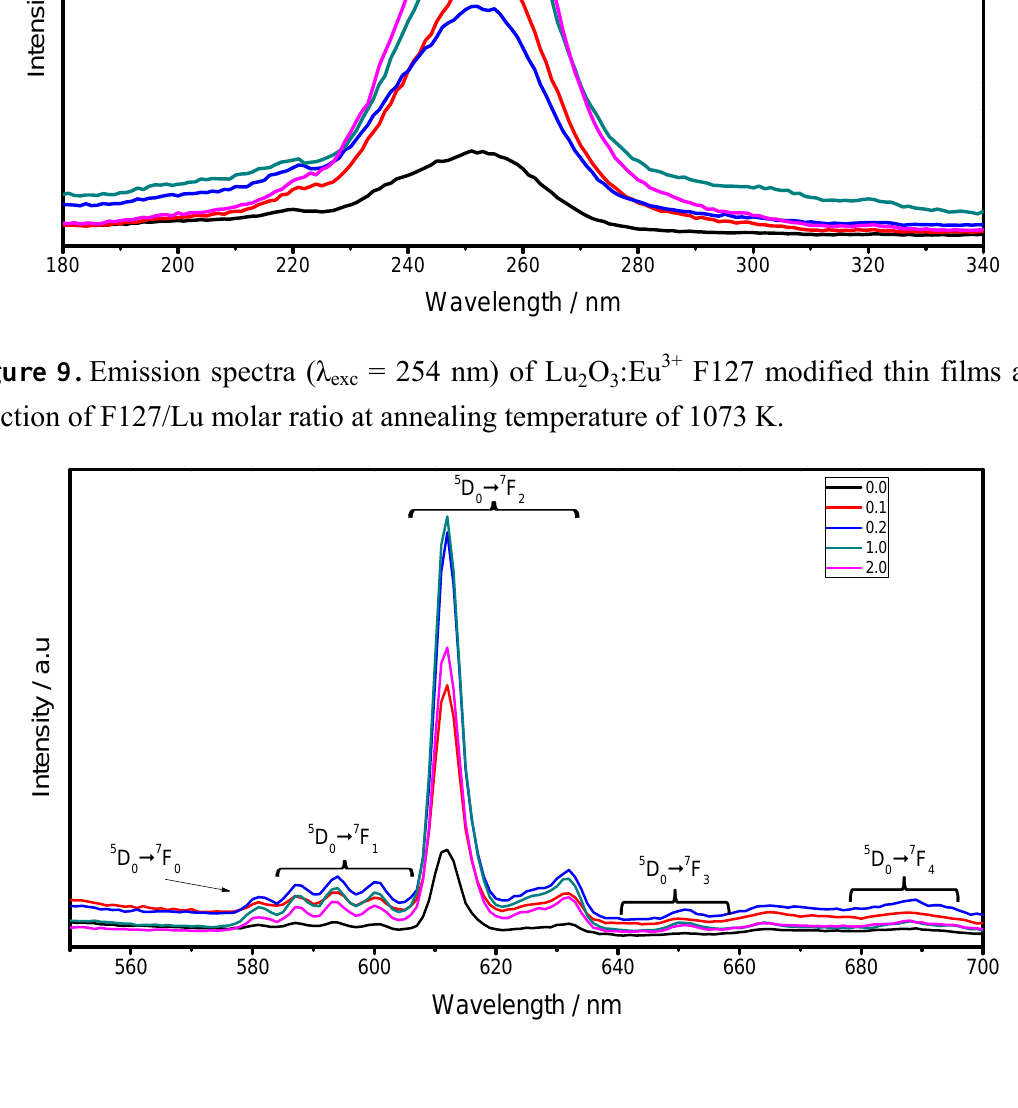
Figure 8. Excitation spectra ( λ function of F127/Lu molar ratio at annealing temperature of 1073 K.